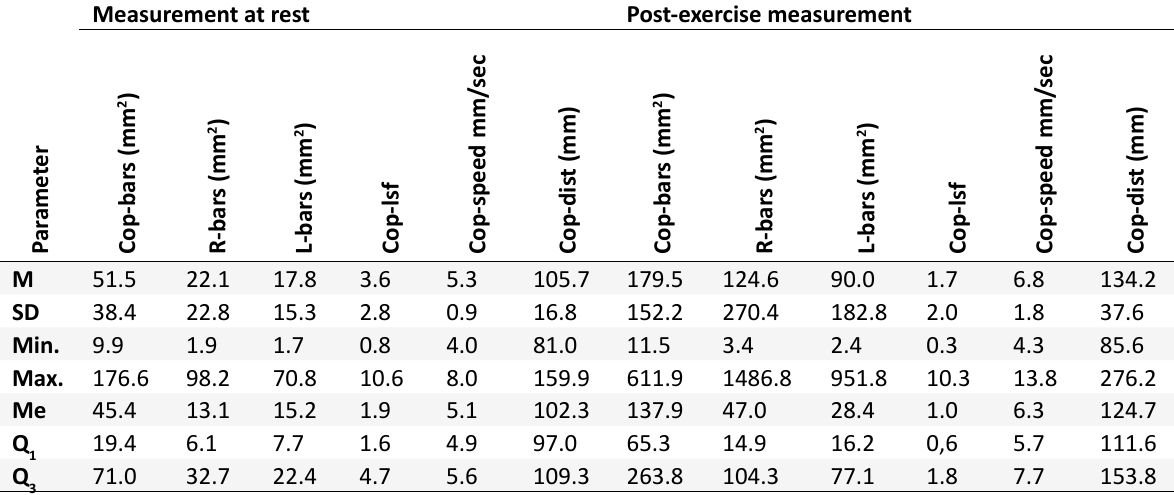
Table 7. Number characteristics of the stabilographic parameters for the female subjects (n=37) Measurement at rest